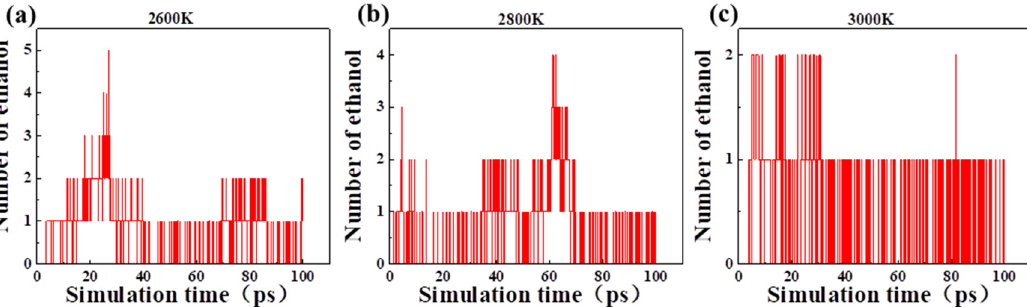
Figure 10. Production of ethanol molecule in the pyrolysis of acetaldehyde and 2,2 ‐ dihydroxyacetaldehyde: ( a ) 2600 K; ( b ) 2800 K; ( c ) 3000 K.